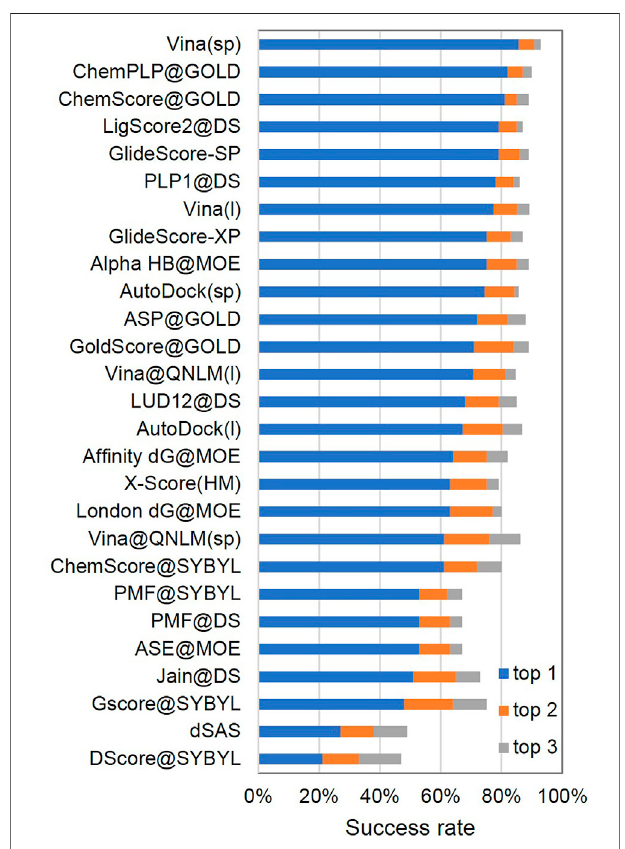
FIGURE 4 | Docking power of top 1 (1%), top 2 (5%), and top 3 (10%) success rates of Vina@QNLM in single-point and local modes (blue, orange, and gray bars), compared to the methods evaluated in CASF-2013 and